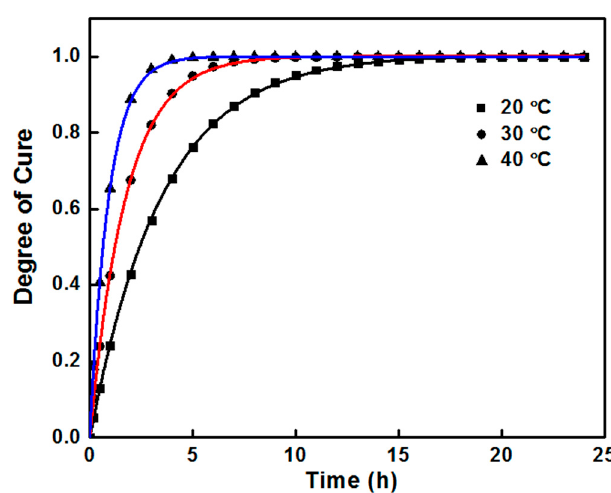
Figure 4. The degree of cure as a function of time at different cure temperature.